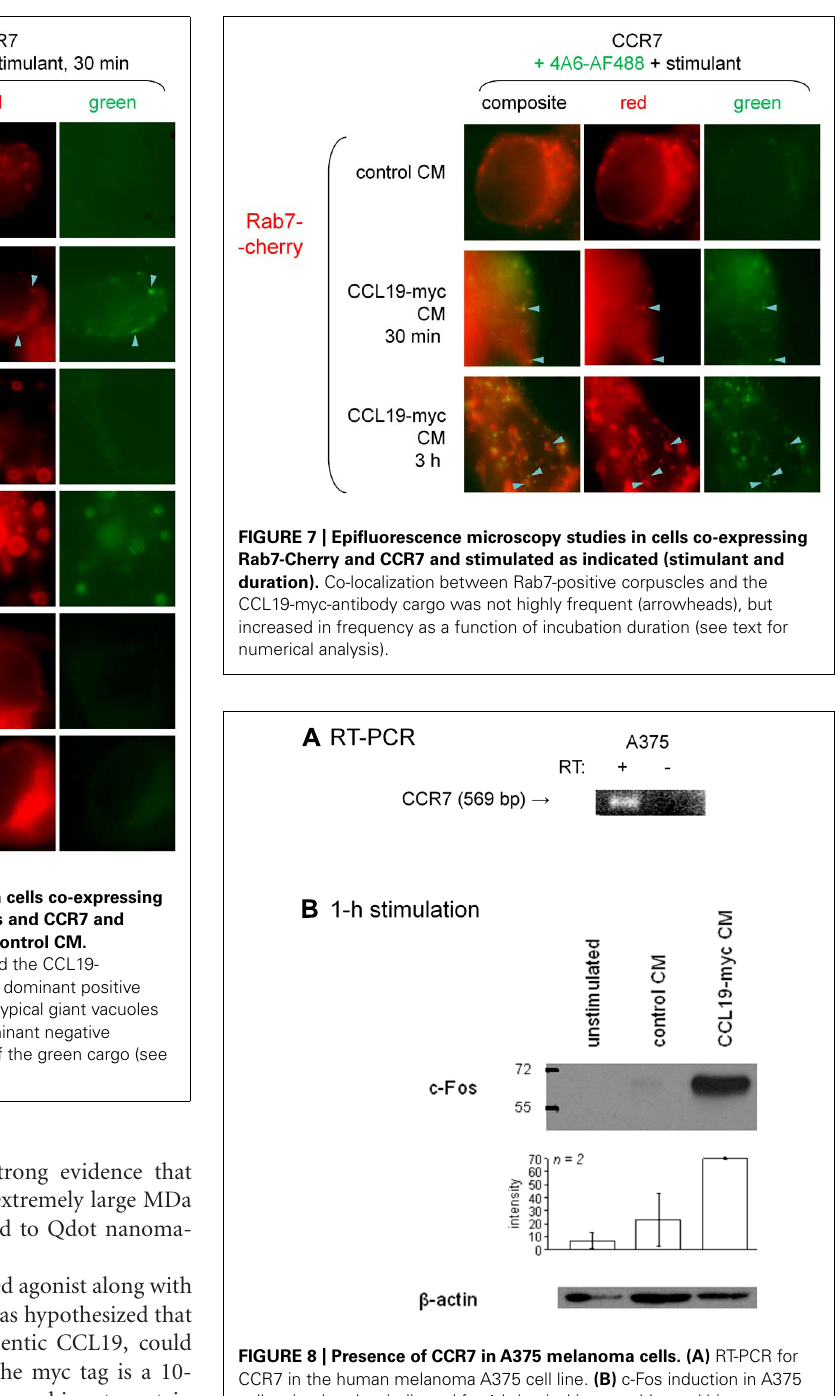
condense β -arrestin 2 -GFP into endosomes ( Figure 5 ). Thus, the C-terminal extension of CCL19 with antigenic tags produced no significant effect on receptor affinity, as predicted from the cur- rent ligand docking model (Ott et al., 2004), and there is no apparent steric hindrance between antibody-bound